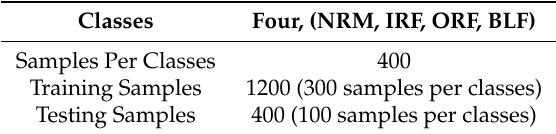
Table 3. Window Characterization for Training and Testing: CWRU